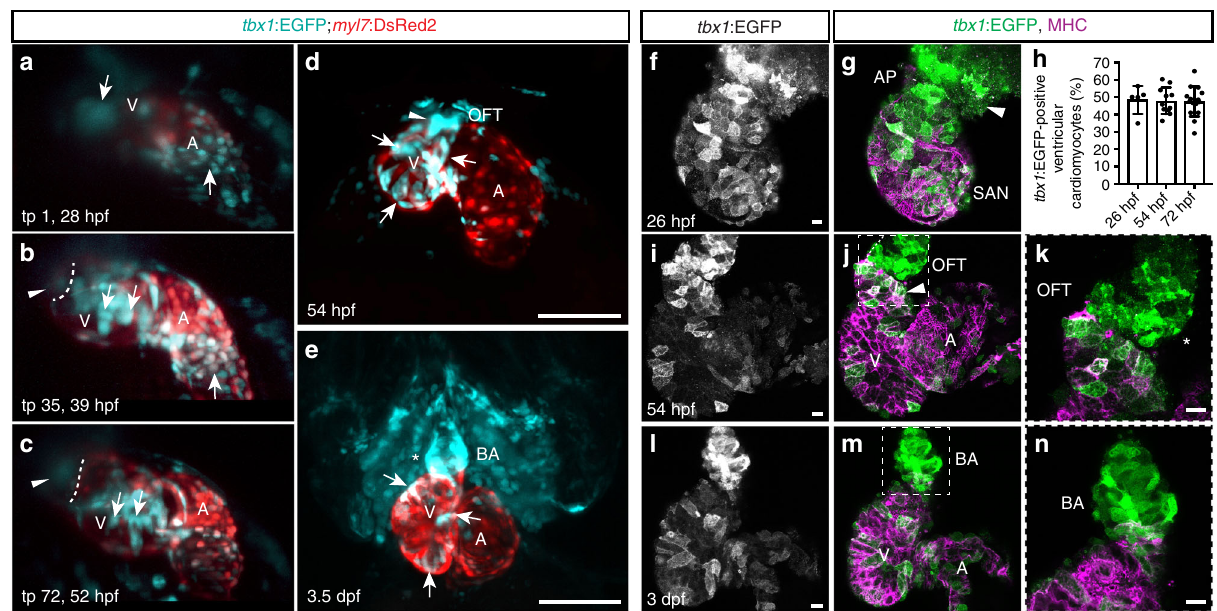
Fig. 4 tbx1 + myocardial precursors connect to the FHF myocardium during heart tube stages. a – c Maximum intensity projections of representative stages of a high-resolution reconstruction of the beating heart of a tbx1 :EGFP; myl7 :DsRed2 double-positive transgenic between 28 and 52 hpf; lateral view (right side) of the embryo, anterior to the top, ventricle to the upper left, atrium to the lower right, and cardiac imaging phase 27 ( n = 1); ventricle (V), atrium (A), and bulbus arteriosus (BA). Arrows indicate tbx1 + / myl7 - cells at the OFT and IFT at the beginning of the time-lapse ( a ) that gradually turn on myl7 reporter expression ( b , c ). The dashed line ( b , c ) indicates the distal end of the ventricle and the arrowheads point to tbx1 :EGFP-expressing cells at the OFT that never cross into the ventricle and are likely BA precursors. d , e Maximum intensity projections of SPIM-imaged tbx1:EGFP ; myl7:DsRed2 double-positive transgenic hearts stopped from contracting with BDM at 54 hpf ( n = 3) or 3.5 dpf ( n = 7), respectively; ventral views, anterior to the top. tbx1 reporter expression can be detected in differentiated tbx1/myl7 reporter double-positive cardiomyocytes (arrows d , e ), the tbx1 + / myl7 - OFT at 54 hpf (arrowhead d ), and the tbx1 + /myl7- BA at 3.5 dpf (asterisk e ). f , g , i – n Top-down 2- µ m confocal section of isolated zebra fi sh hearts at 26 ( f , g ), 54 ( i – k ), and 72 hpf ( l – n ) from tbx1 :EGFP, counterstained with anti-GFP and anti-MHC; OFT/BA to the top, sinoatrial node (SAN) or atrium (A) to the bottom left, and ventricle (V) to the top left. k , n A magni fi cation of the framed area in j , m . f , g tbx1 :EGFP is expressed at the MHC-negative arterial pole (AP) of the heart tube (arrowhead). h Quanti fi cation of the tbx1 :EGFP-positive ventricular cardiomyocytes compared to whole ventricle (in percentage) reveals no change over developmental period from 26 hpf ( n = 5), 54 hpf ( n = 11), to 72 hpf ( n = 15). Each data point represents averaged percentage per heart; means ± s.d. i – k At 54 hpf, cardiomyocytes of the later-differentiated distal ventricle express tbx1 :EGFP (arrowhead), as do MHC-negative progenitors of the OFT (asterisks). l – n The differentiated BA at 3 dpf is positive for tbx1 :EGFP. Scale bars 200 µ m ( d , e ), 10 µ m ( f , g , i – n